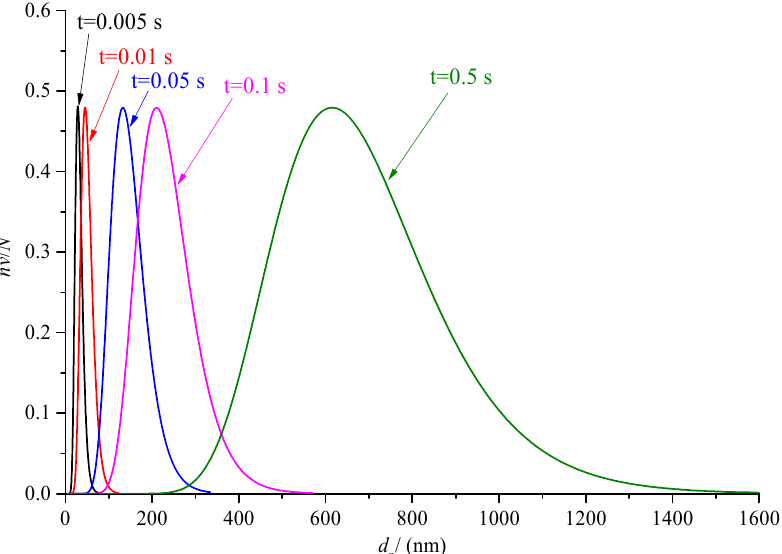
Figure 21. Comparison of sulfur particle size distribution at different time under conventional co- ordinates ( nv / N ).